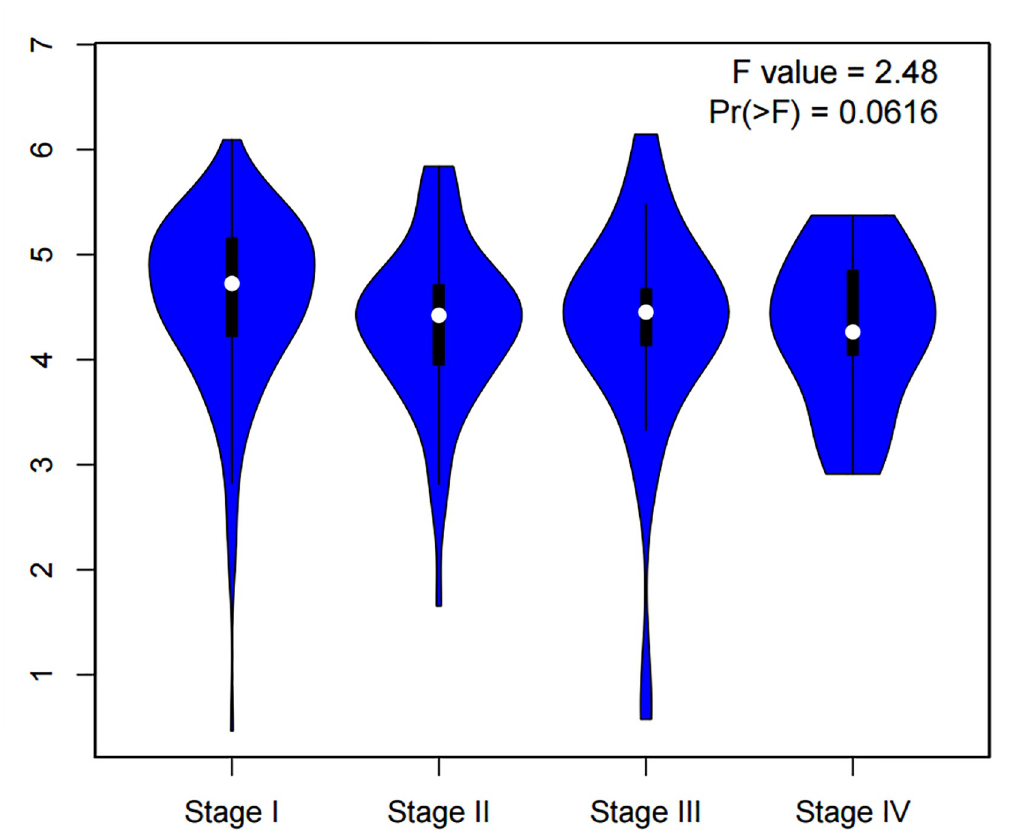
Fig 6. The levels of MGMT expression in different FIGO stage of cervical cancer ( p > 0.05) from GEPIA